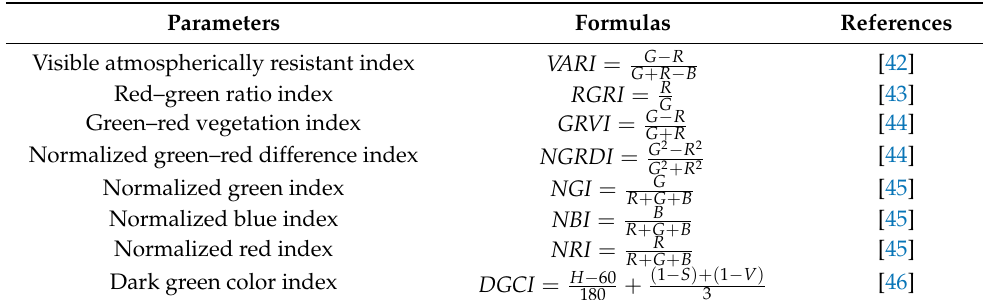
Table 4. RGB (red–green–blue) vegetation